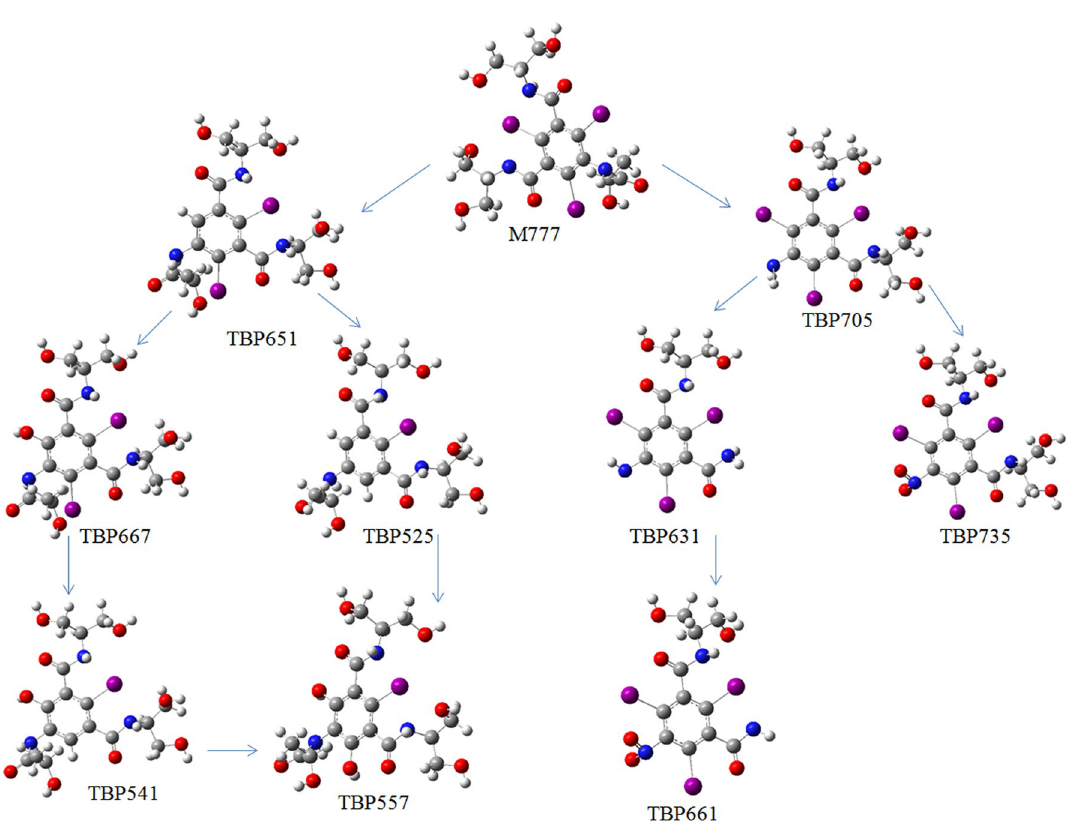
Figure 5. Possible degradation pathways of IPM by Fe(II)/PS